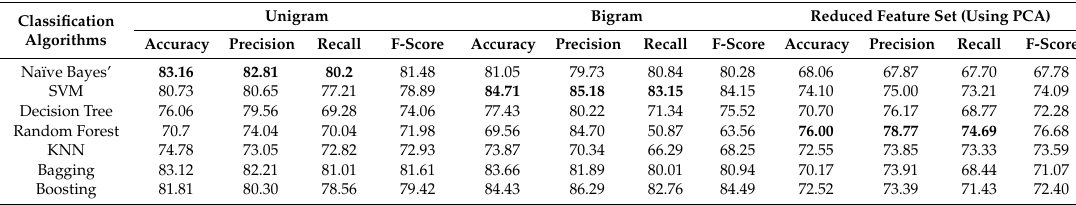
Table 5. Average score on unigram, bigram feature set and Principal Component Analysis (PCA)-based reduced feature